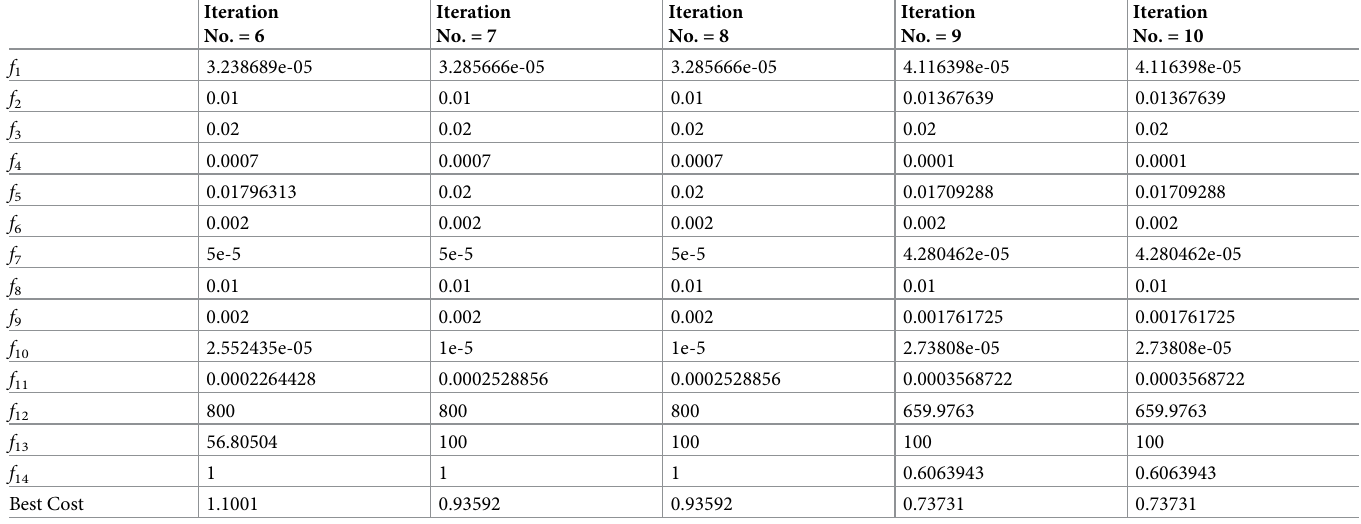
Table 4. The achieved results when using the Jaya algorithm (continued). Iteration No. =